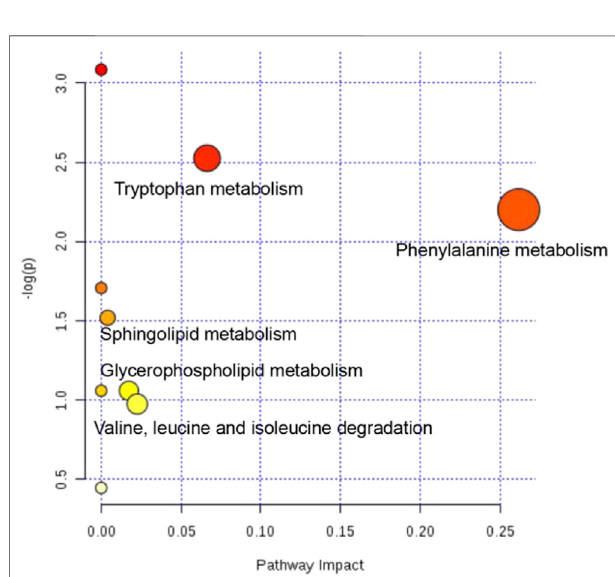
FIGURE 9 | Analysis diagram of metabolic pathway of potential biomarkers. Each point represents one metabolic pathway. The size of dot and the shade of color are positively related to the effect on metabolic